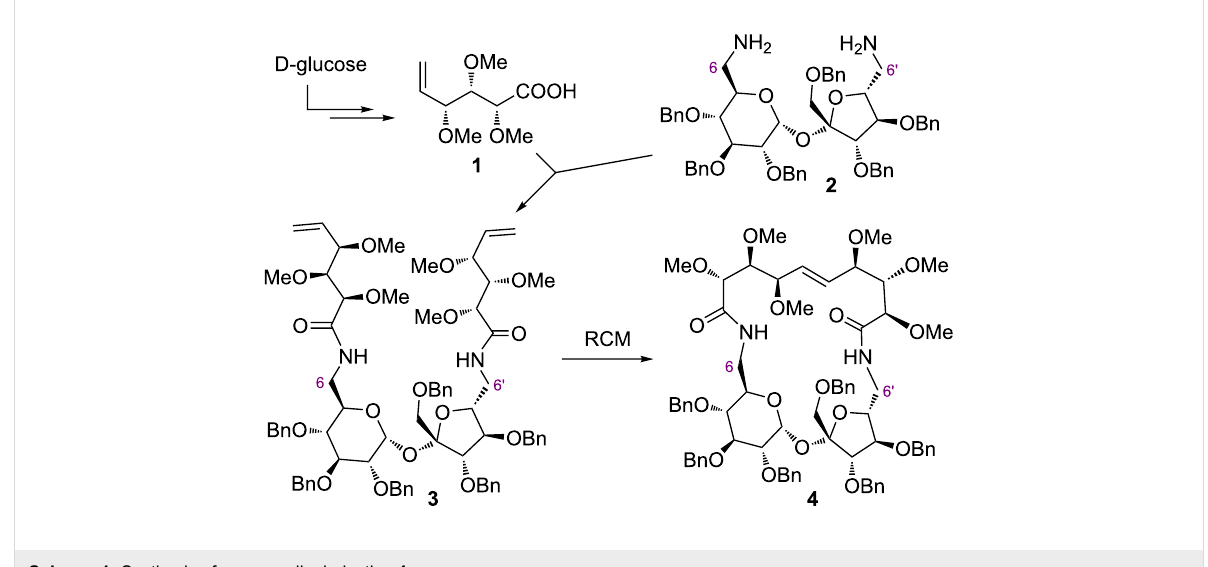
Scheme 1: Synthesis of macrocyclic derivative 4 .